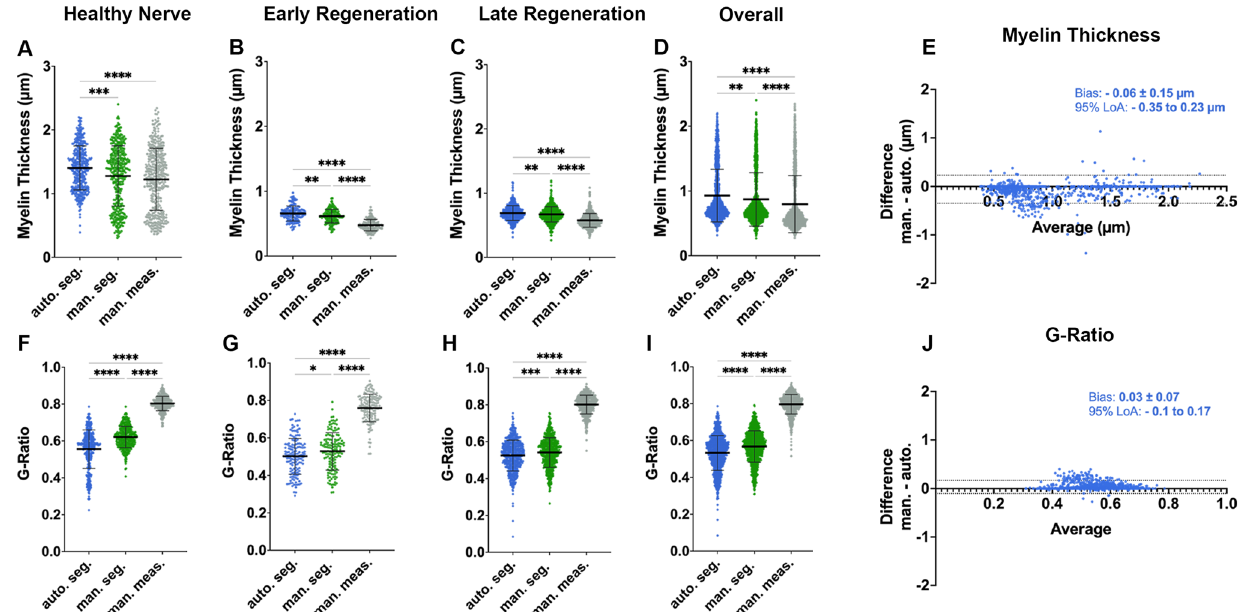
Figure 4. Automated myelin sheath thickness measurements and g-ratio calculations. ( A ) Comparison of myelin sheath thickness results obtained from automated segmentations (blue), ground truth labels (green) and manual morphometry (grey) for healthy nerves, ( B ) early nerve regeneration stages, ( C ) late regeneration stages and ( D ) all samples combined. ( E ) Nerve fiber specific comparison in a bland–Altman plot showing good agreement of the AxonDeepSeg automated histomorphometry (auto.), with myelin thickness measurements in the ground truth (man.). We observed a tendency of AxonDeepSeg to overestimate the myelin thickness by 0.06 ± 0.15 µm on average (bias) with the 95% limits of agreement (LoA) being -0.1 µm to 0.17 µm. ( F ) Comparison of the g-ratio calculations obtained from automated segmentations (blue), ground truth labels (green) and manual morphometry (grey) for healthy nerves, ( G ) early nerve regeneration stages, ( H ) late regeneration stages and (I) all samples combined. As a result of the axon diameter overestimation and underestimated myelin sheath thickness in manual measurements (grey), the g-ratios calculated from these metrics deviated drastically from the ground truth. ( J ) Nerve fiber specific comparison of the g-ratios in a bland–Altman plot showing an acceptable agreement of the automated histomorphometry via AxonDeepSeg (auto.) with the ground truth measurements